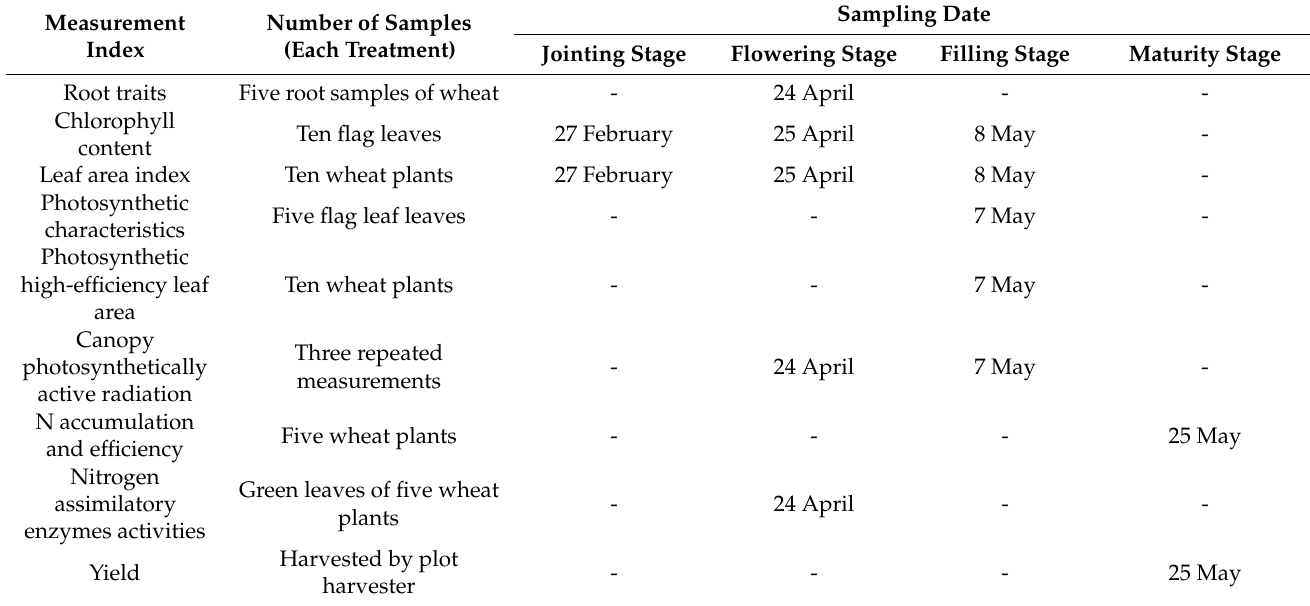
Table 1. The number of samples and sampling